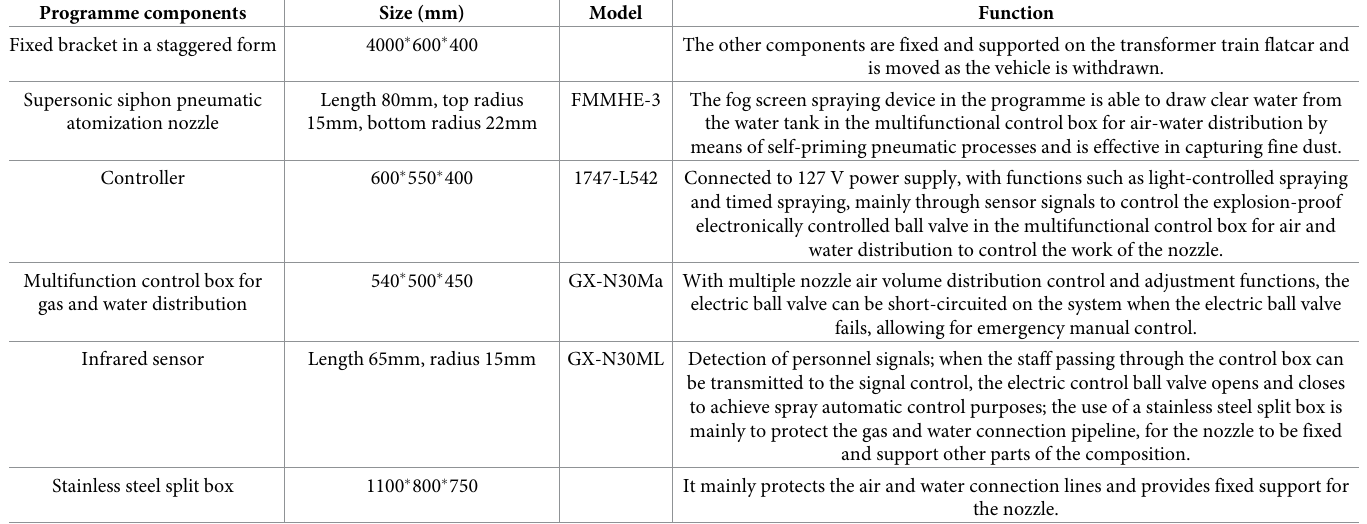
Table 3. Functions of dust control technical